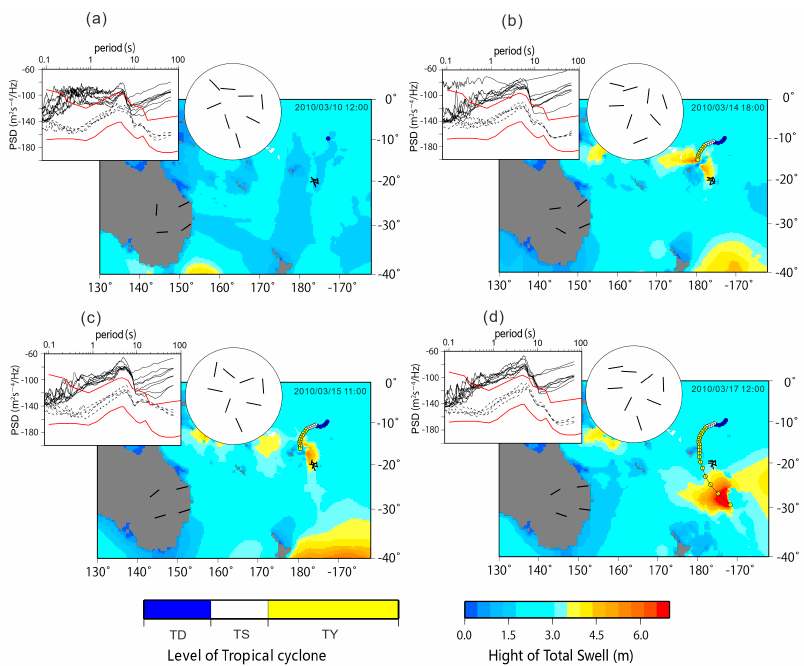
Figure 4. Back azimuth, black bar, and power spectral density from polarization analysis for YL and AU at four different times. ( a ) 10 March 2010 12:00; ( b ) 14 March 2010 18:00; ( c ) 15 March 2010 11:00; ( d ) 17 March 2010 12:00. Inset upper left is the PSDs for YL, black line, and AU stations, the dashed line. Inset circle is the zoom-in to show the back azimuths for YL